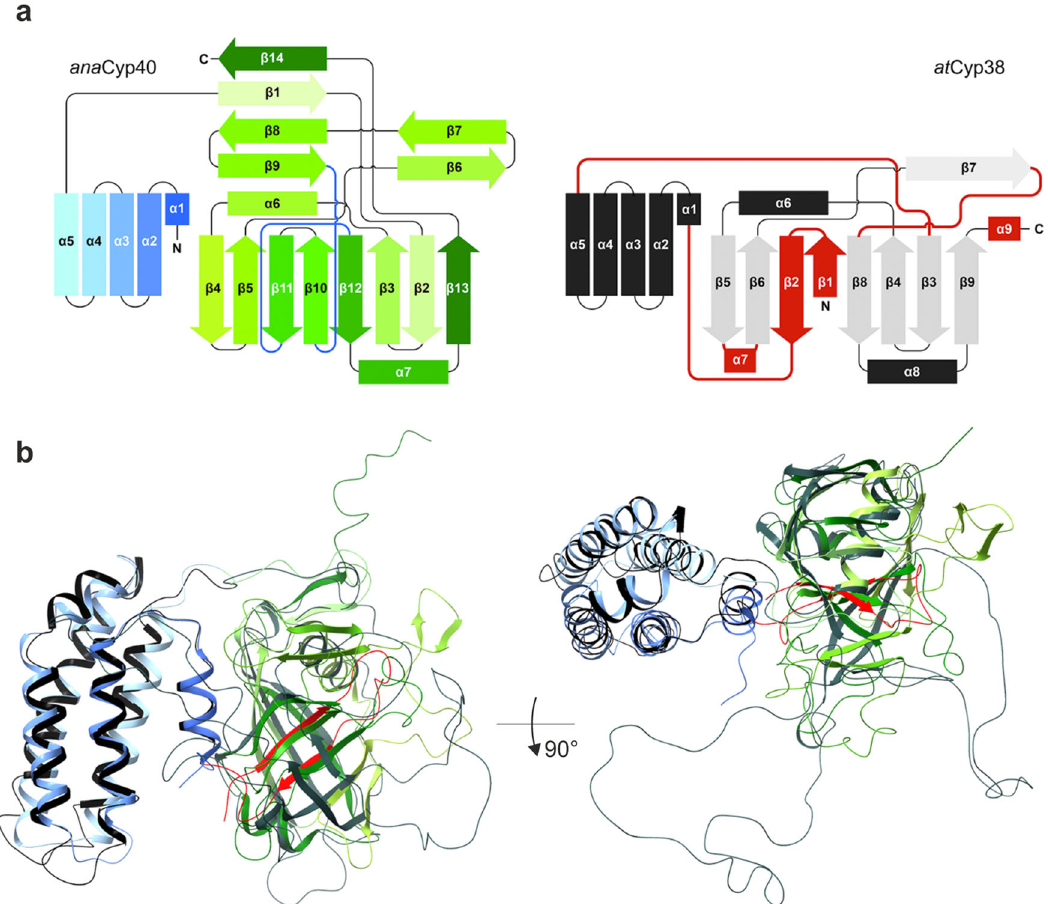
Fig. 7 Topological and structural comparison of ana Cyp40 and at Cyp38. a The topological organization of structural elements in ana Cyp40 is shown on the left and of at Cyp38 (pdb-id: 3rfy) on the right. In ana Cyp40 the Q-domain is shown in blue colors and the C domain in red colors. The loop regions interacting with helix α 1 are shown as blue lines. β -strands β 2- β 5 and β 10- β 13 form the 8-stranded β -barrel. In at Cyp38 the structural elements of Q-domain are shown in black and of the C-domain in gray. Strong discrepancies to the topology of ana Cyp40 are indicated in red. b The structural comparison of ana Cyp40 and at Cyp38 from two perspectives shows a very similar organization of the Q domain whereas the similarities in the C-domain are restricted to the β -barrel and the helices surrounding the β -barrel. Compared to the unstructured long loops that connect the helices and β -strands of the β -barrel in at Cyp38, the loops in ana Cyp40 are shorter and have structural elements like β -hairpins and short β -sheets. Coloring of the structural elements in ana Cyp40 is according to Fig. 6. The topological discrepancies are highlighted in red also in the structure of at